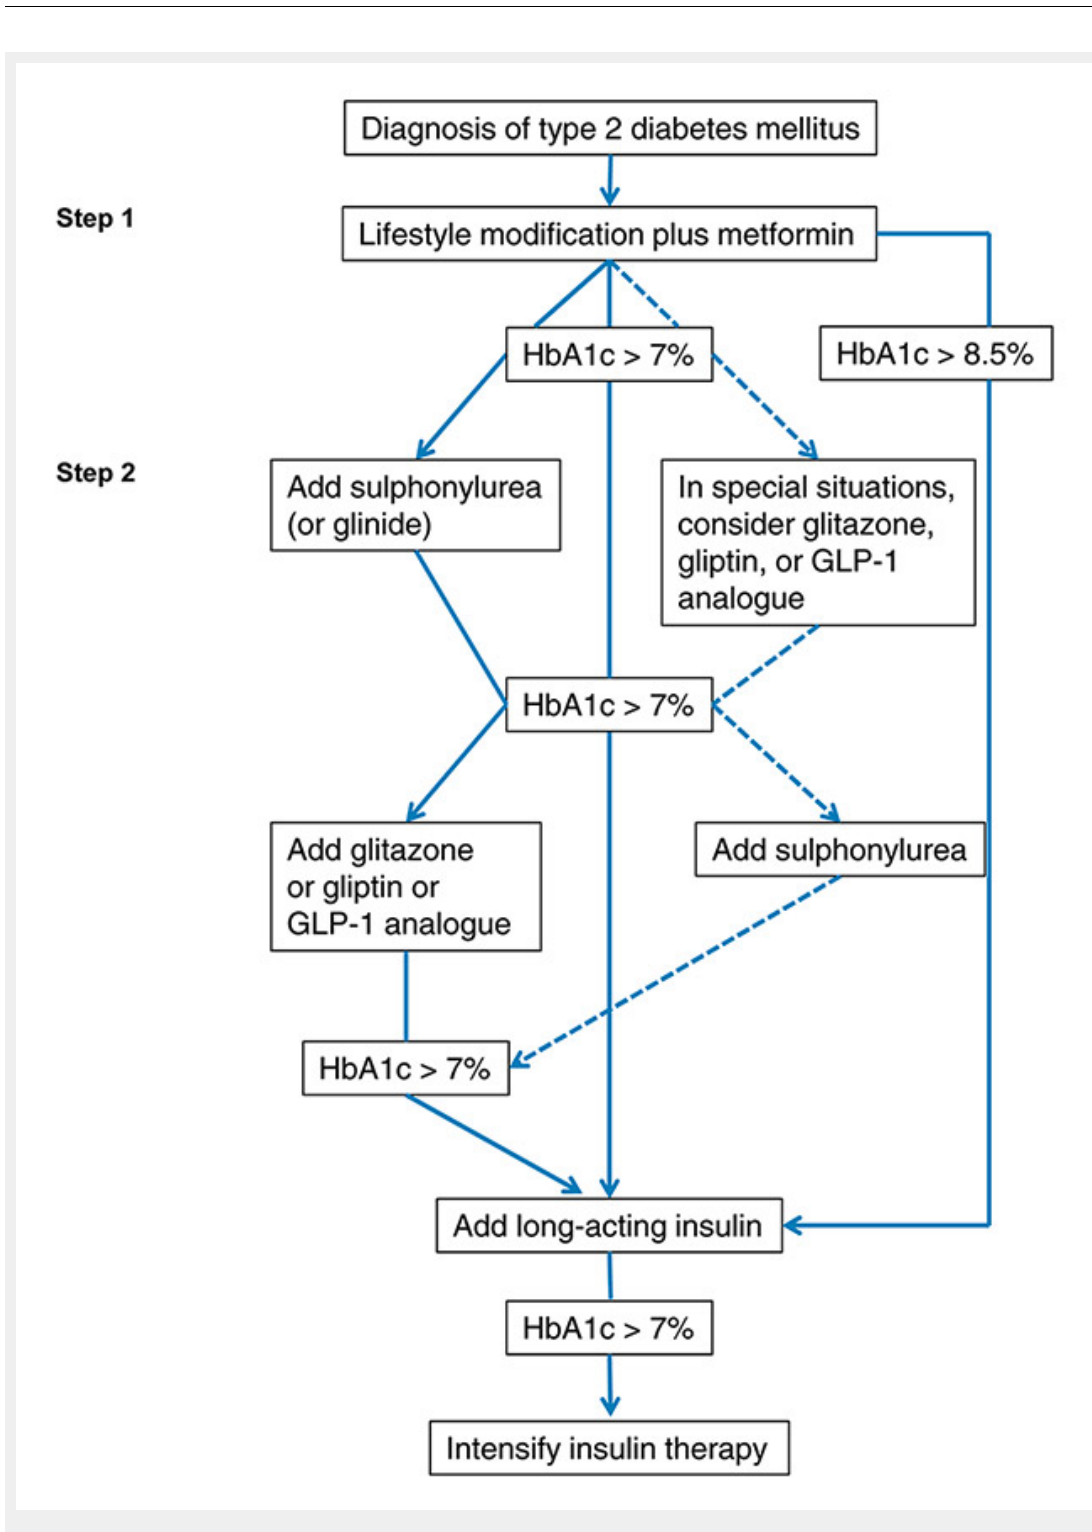
Figure 1 SSED 2009 treatment recommendations for type 2 diabetes. Adapted, with permission, from reference 4 (Swiss Med Forum 2009;9(3):50-5. [http://www.medicalforum.ch]). GLP-1 = glucagon-like peptide-1; HbA1c = glycated haemoglobin